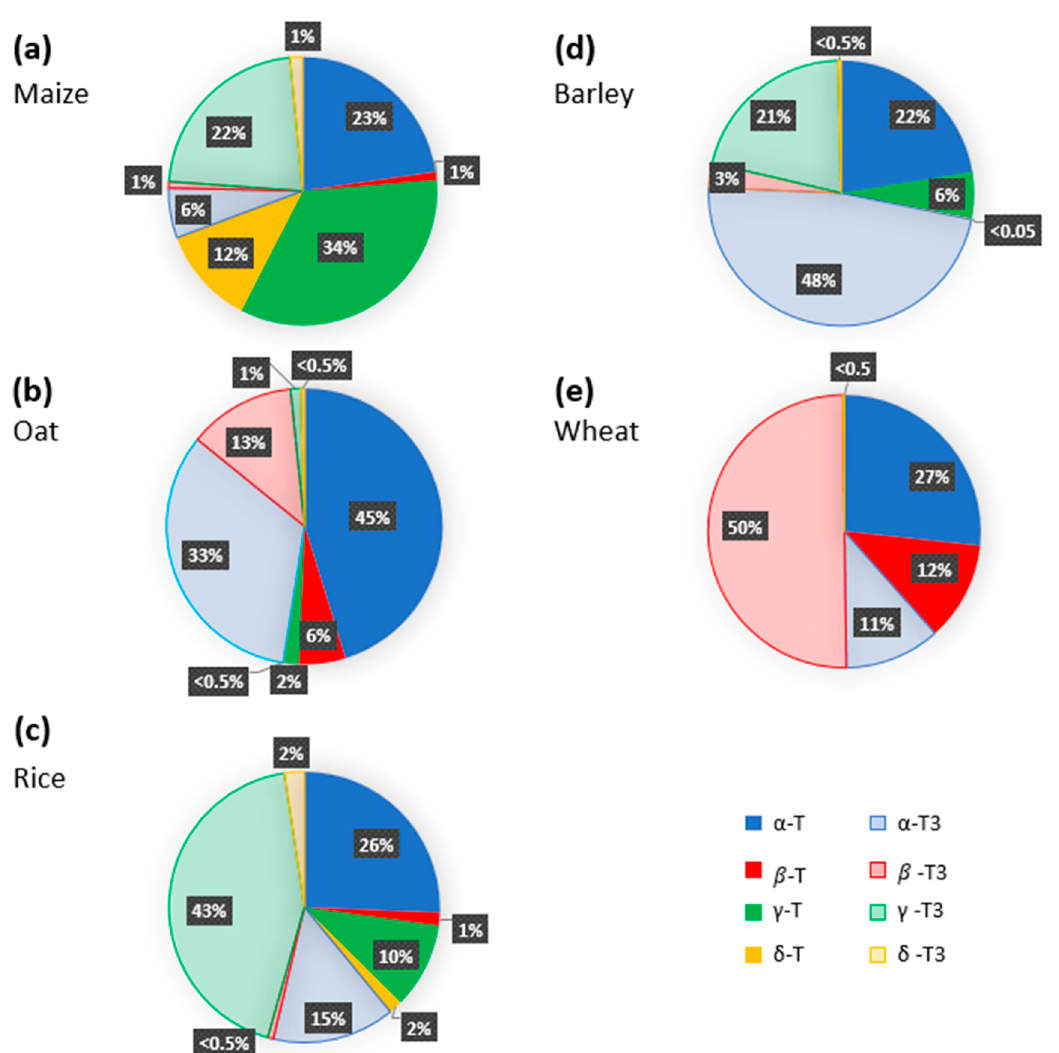
Figure 3. Tocochromanol profile of major cereal crops (( a ) Maize; ( b ) Oat; ( c ) Rice; ( d ) Barley; ( e ) Wheat). The percentages were calculated using average concentration of tocochromanols reported